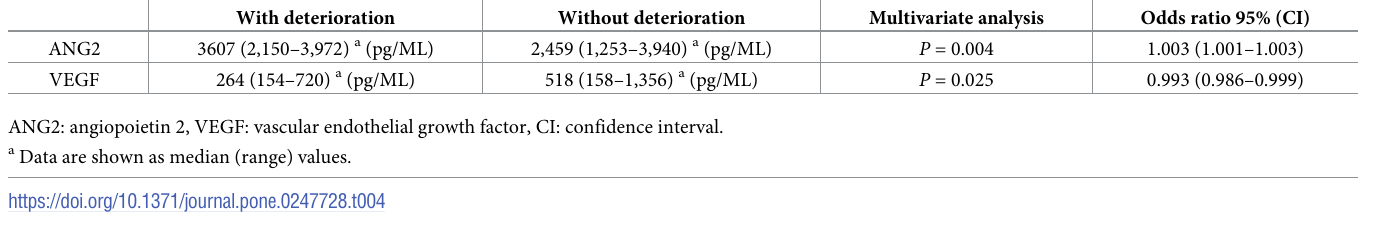
Table 4. Multivariate analysis for factors associated with the deterioration of liver functional reserve during lenvatinib treatment. With deterioration Without deterioration Multivariate analysis Odds ratio 95% (CI) ANG2